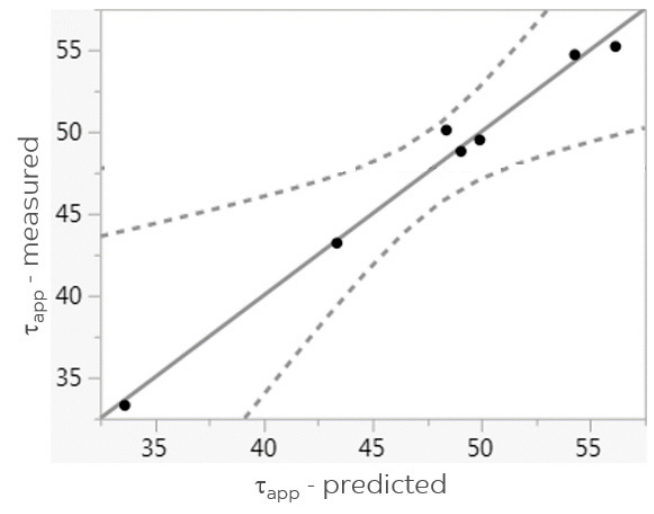
Figure 7. Linear correlation between τ app predicted (Equation 2) and τ app measured (samples 1–7).